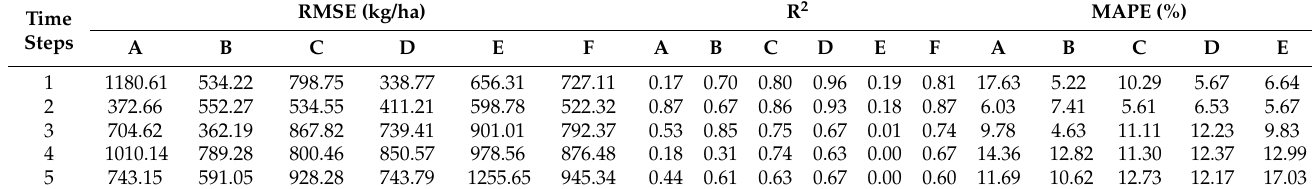
Figure 7. Comparison of the yield estimation results for LSTM models based on different time steps ( A ) one time step; ( B ) two time steps; ( C ) three time steps; ( D ) four time steps; ( E ) five time steps; and ( F ) six time steps. The probability distributions of the statistical and estimated yields are plotted on the right and top of the Y axis, respectively.